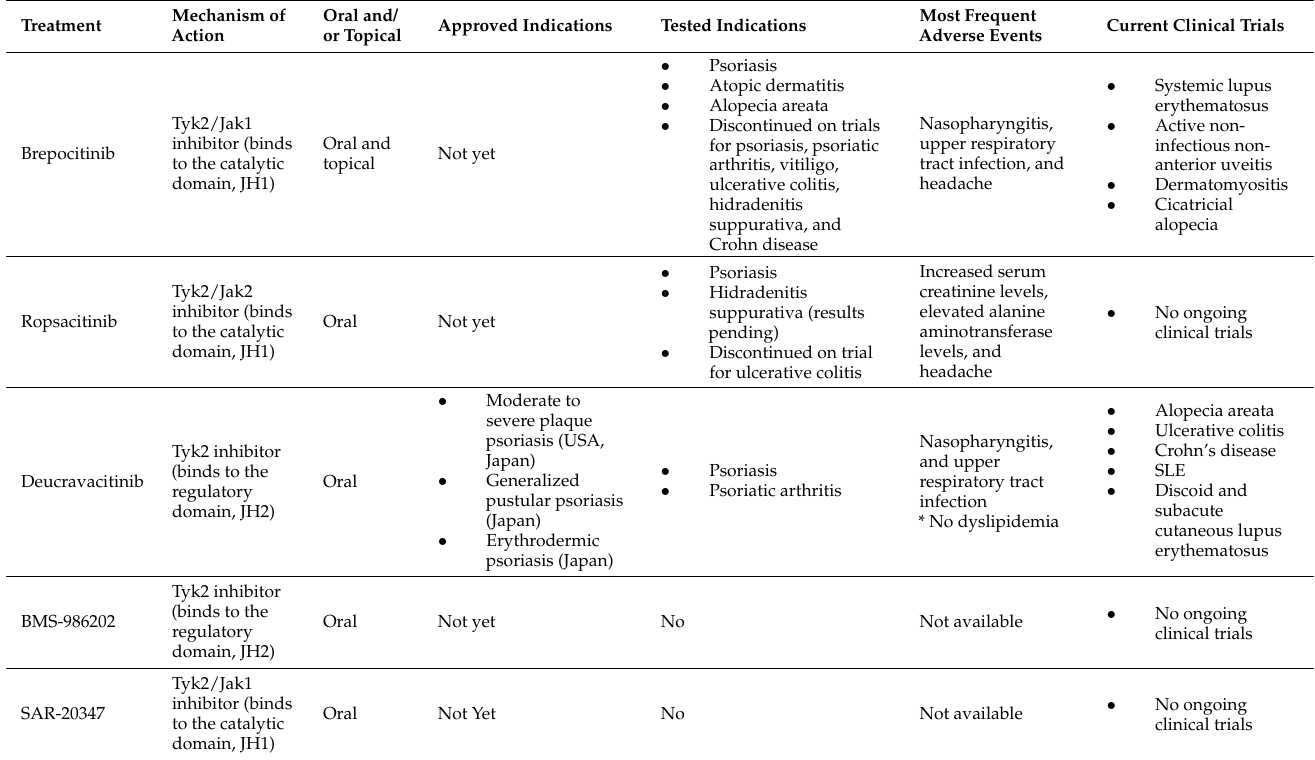
Table 1. Summary of the main characteristics of the Tyk2 inhibitors discussed in this